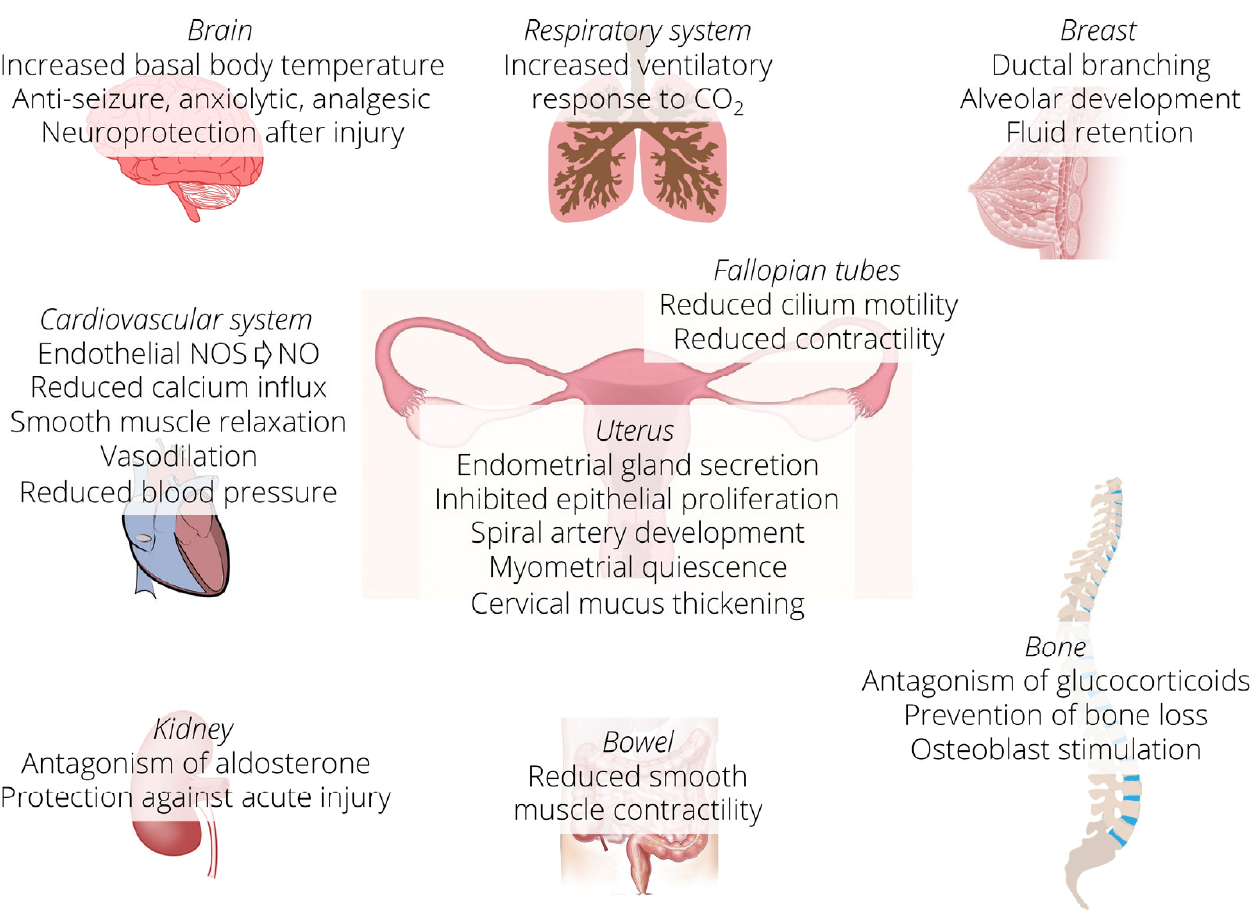
Figure 1. Schematic representation of the organs in which progesterone performs functions. Progesterone acts in reproductive as well as in non-reproductive tissues. NOS = nitric oxide synthase, NO = nitric oxide. Two isoforms of PR are transcribed from a single gene by alternative splicing